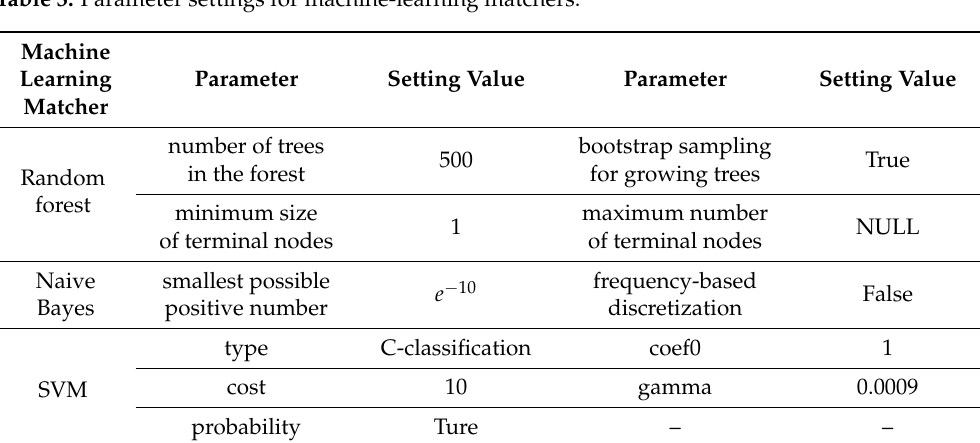
Table 3. Parameter settings for machine-learning